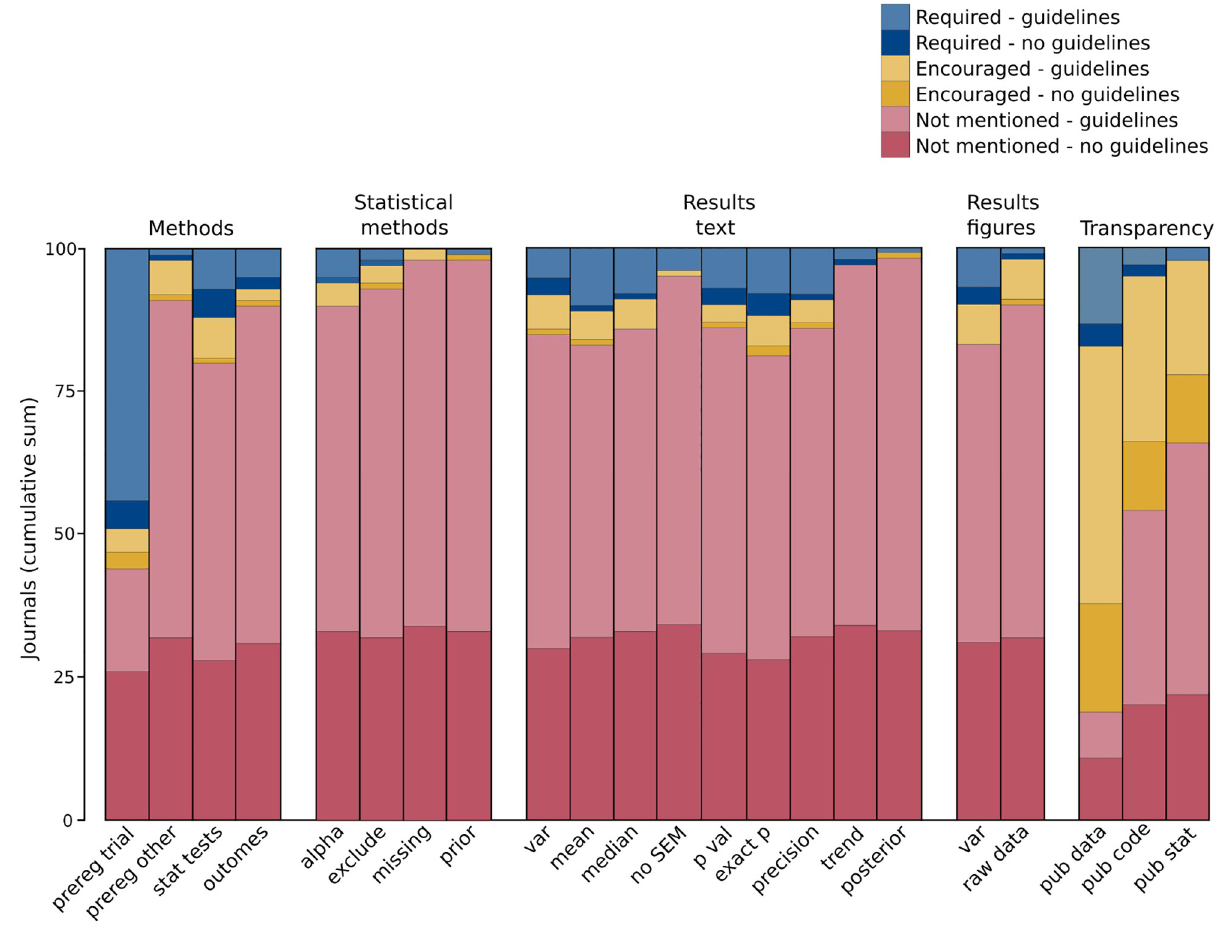
Fig 1. Audit results. Number of journals that addressed responsible practices in reporting research. Scores of Required , Encouraged and Not mentioned are presented stratified by whether journals referenced external guidelines and checklists ( - guidelines ; lighter colours) or did not reference external guidelines and checklists ( - no guidelines , darker colours). Refer to Table 1 for wording of questions and variable names in this figure.